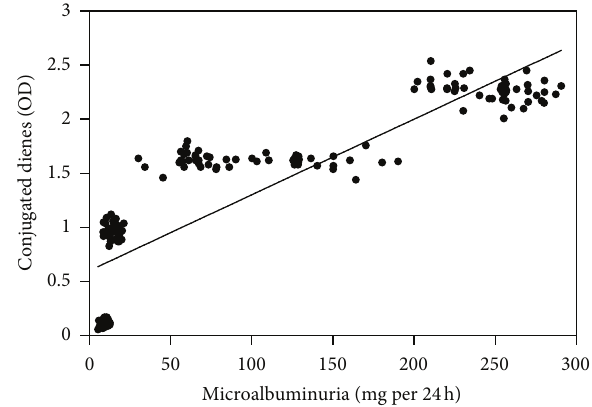
F 1: Correlation between microalbuminuria levels and nitro- tyrosine.